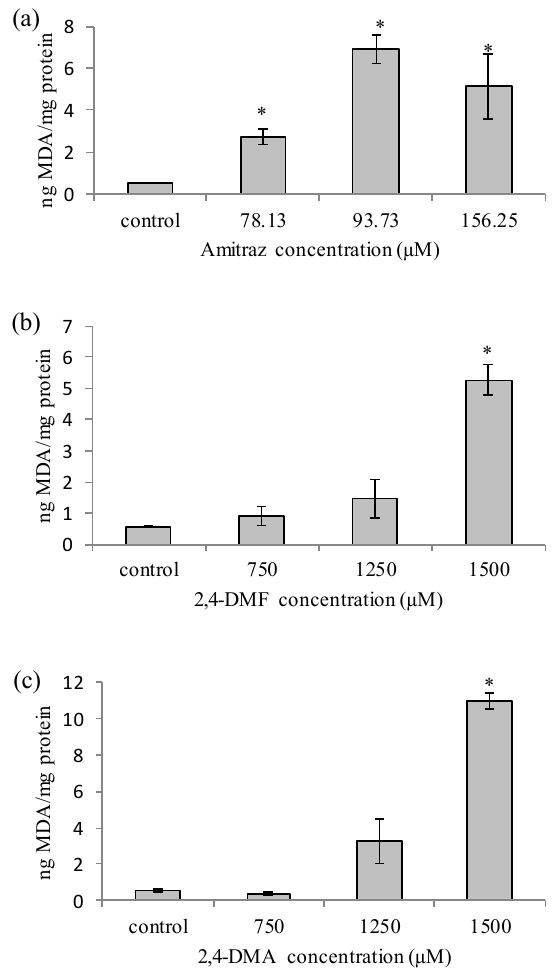
Figure 1. Lipid peroxidation production in HepG2 cells for ( a ) amitraz, ( b ). N -(2,4-Dimethylphenyl)formamide (2,4-DMF) and ( c ) 2,4-Dimethylaniline (2,4-DMA) after 24 h of exposure. Results are expressed as mean ± SEM ( n = 3) in ng of Malondialdehyde (MDA)/mg of protein measured by Bradford method. (*) p ≤ 0.05 indicates significant differences from control.